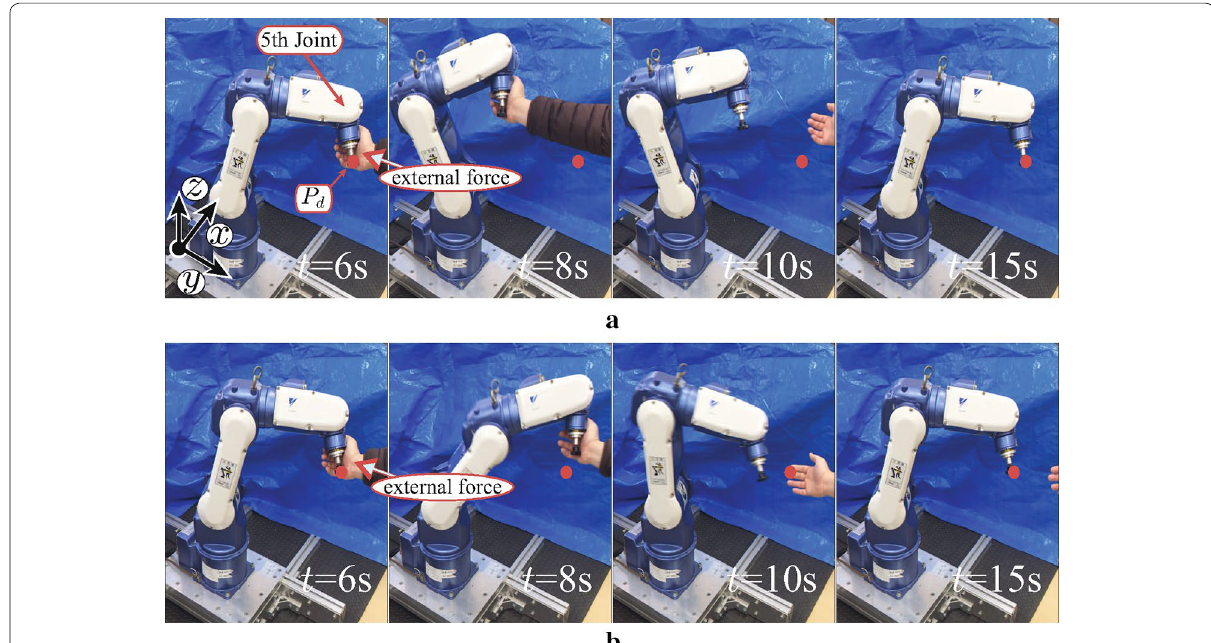
Fig. 8 Situations of Experiment III. a The robot is moved by the experimenter’s hand under cN1 . b The robot is moved by the experimenter’s hand under cSPID . Both ( a , b ) are with the initial configuration F, which is ( p d = [ 0.38,0.13,0.44 ] T m,Q α d = [− 0.157,0.515, − 0.078 ] T